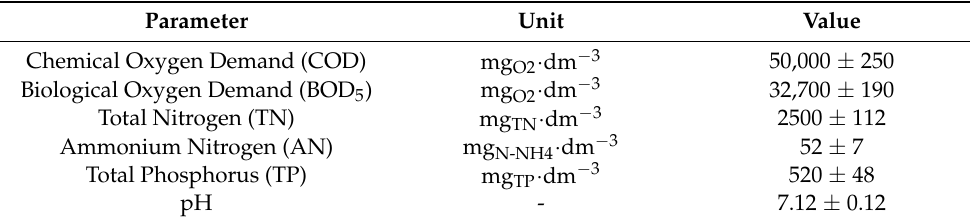
Table 2. Profile of the liquid dairy waste (LDW) used in the